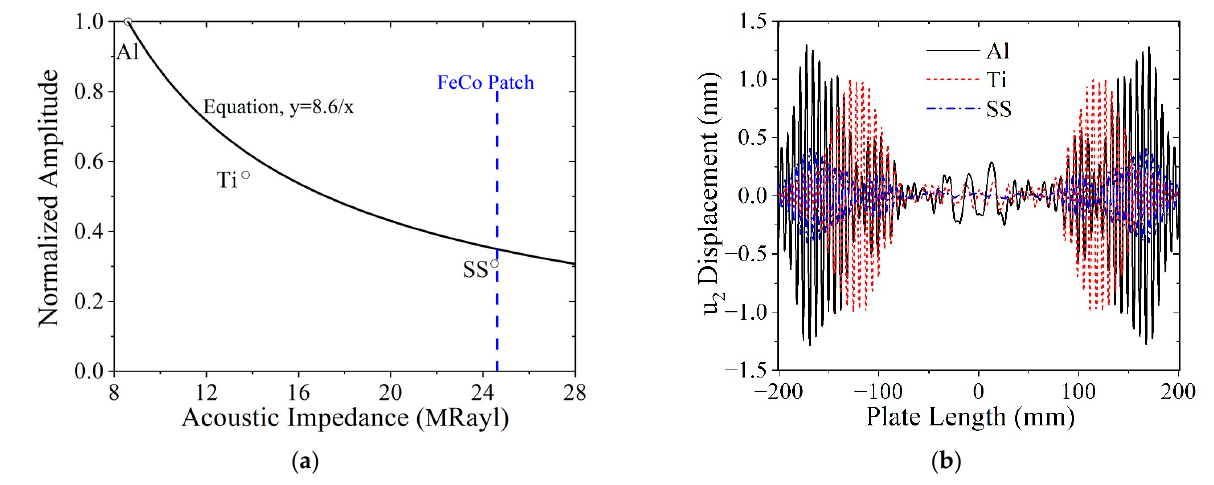
Figure 6. Acoustic impedance mismatch effect on MST performance: ( a ) SH0 wave amplitude decrease as a function of plate acoustic impedance; ( b ) u 2 displacement field at 60 μ s generated by the MST on different plates.